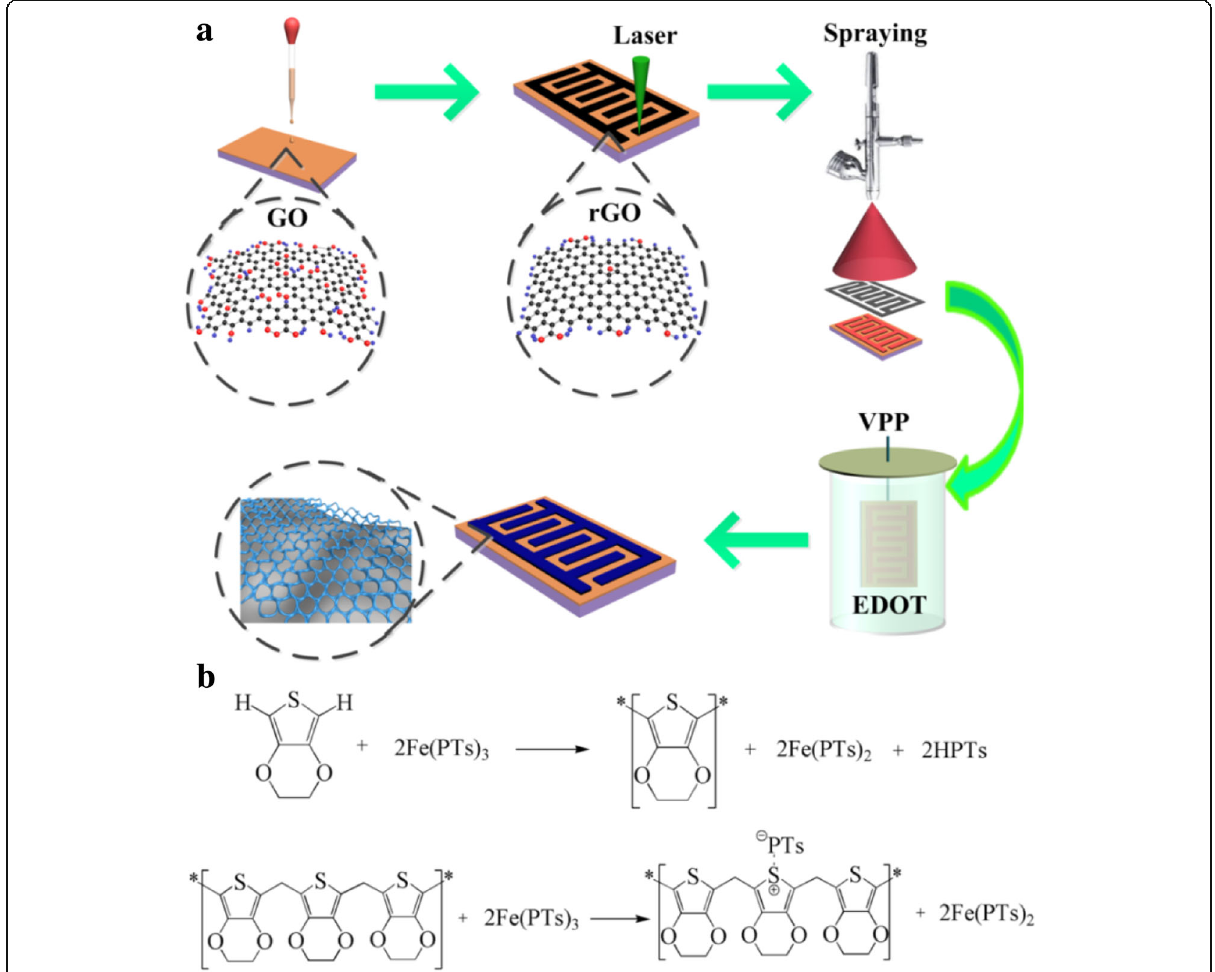
Fig. 1 a Schematic illustration of the fabrication of rGO/PEDOT interdigitated electrodes. b The polymerization mechanism of